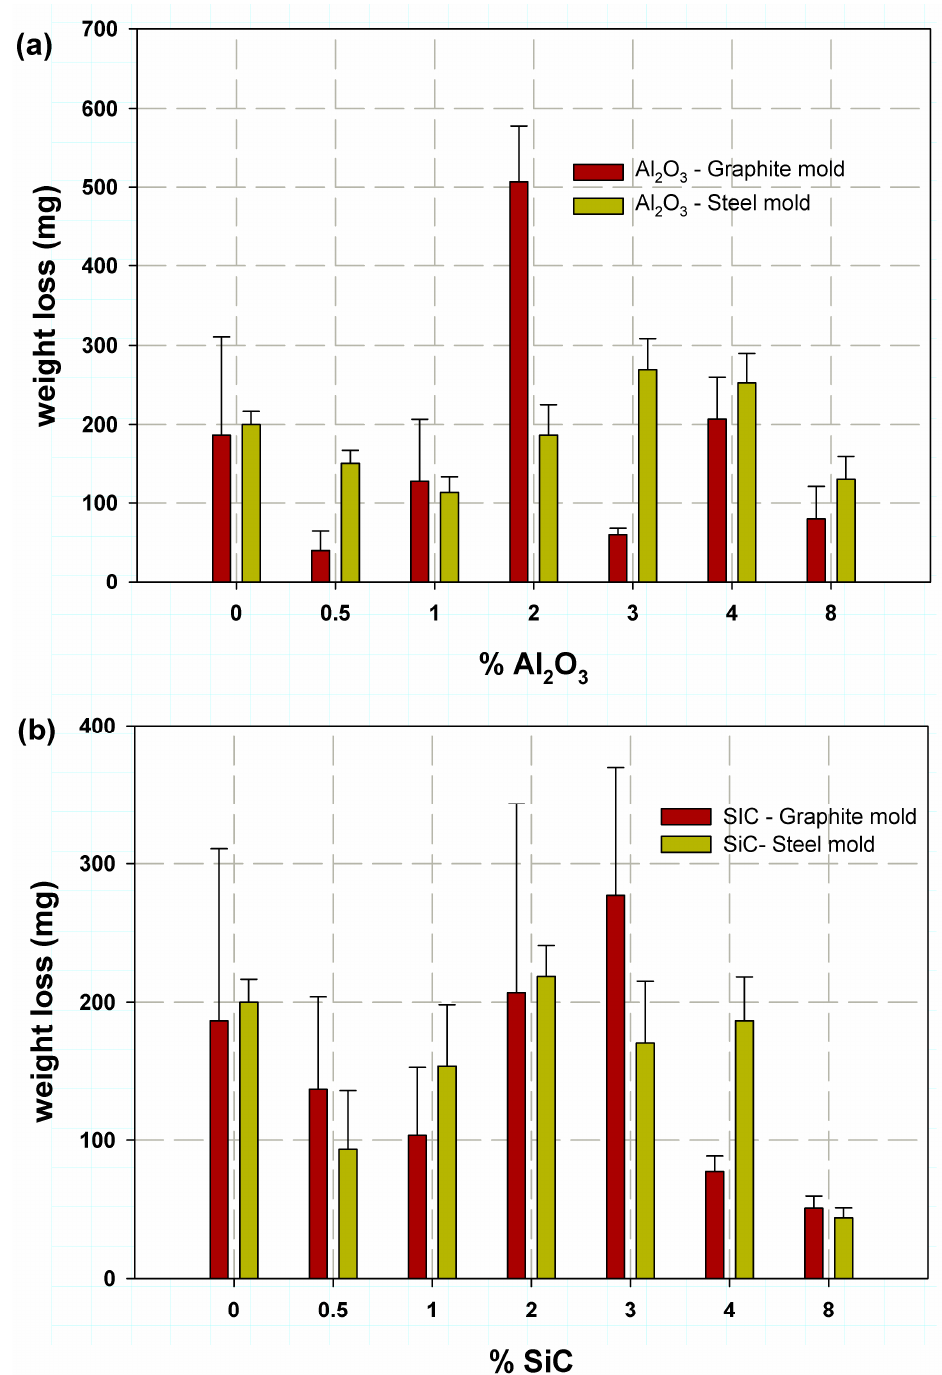
Figure 10. Average weight loss variation at 3.5 m/min velocity for Al-Si-Mg alloy filled with ( a ) Al 2 O 3 , ( b ) SiC.